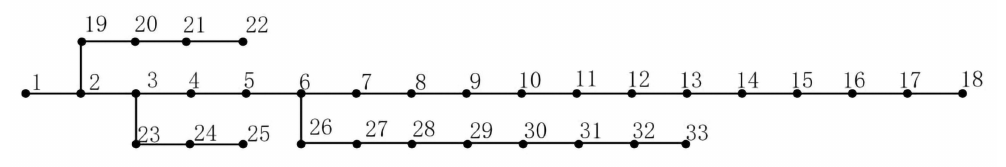
Figure 7. The topology diagram of IEEE-33 bus system.